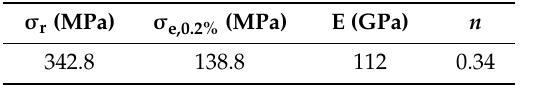
Table 1. Mechanic properties of the 0.5 mm Cu-ETP wire.